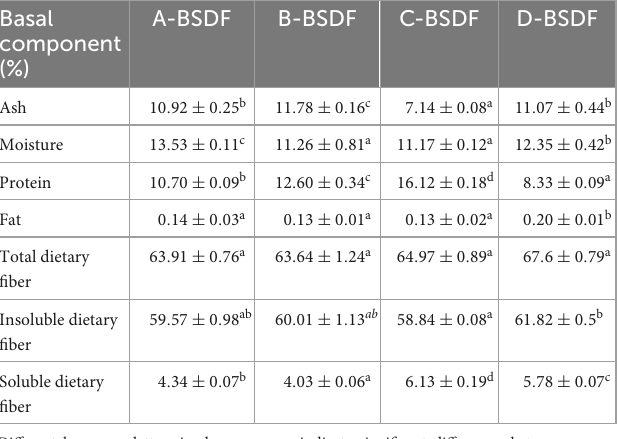
FIGURE2 Size distribution chart.